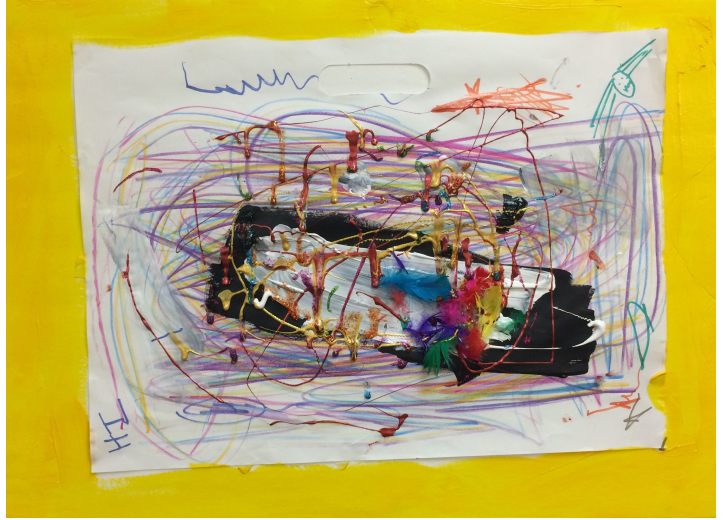
Figure 6Figure 6. Bringing mom into the mess/Inside. 11 × 18”, colored paper, markers, acrylic paint,